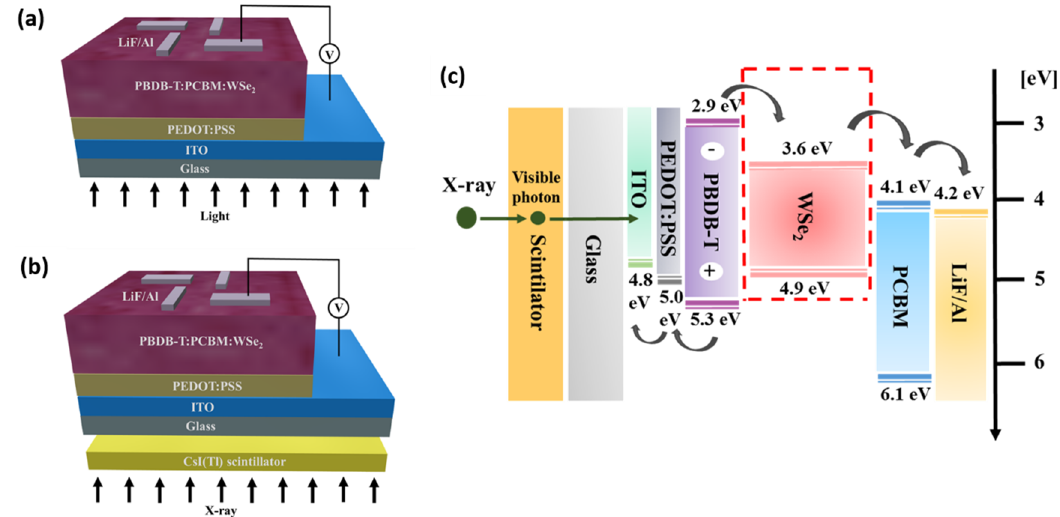
Figure 5. Schematic illustration of ( a ) hybrid polymer solar cell structure; ( b ) X-ray detector structure combined with ScI(Tl) scintillator; ( c ) energy level diagram of the device.